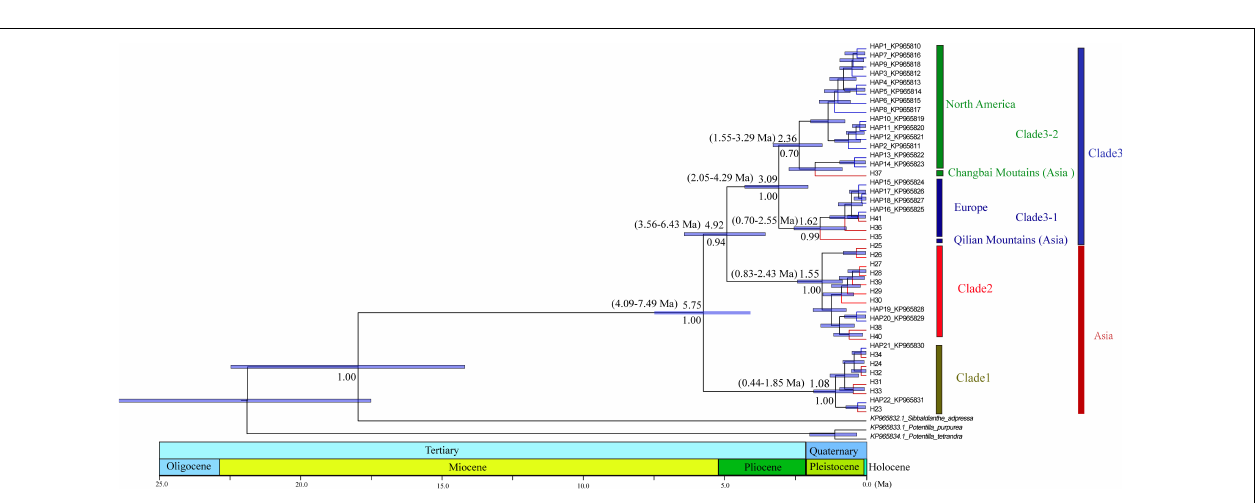
FIGURE 2 | Unrooted haplotype network with SAMOVA defined groups, the size of the circles represents the frequency of haplotypes, with larger circles representing haplotypes found more frequently than smaller circles.